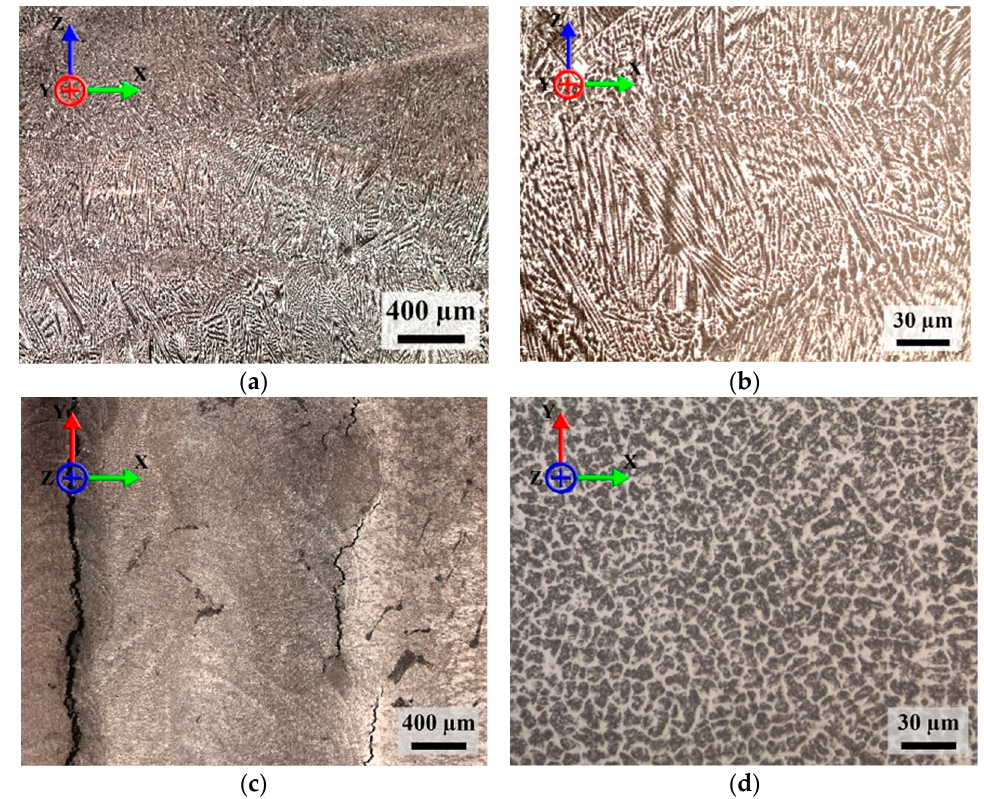
Figure 6. Microstructure of a H13 steel sample L-DED manufactured with US, where ( a ) and ( b ) are the perpendicular direction ( Y ), in line with the building direction, and ( c ) and ( d ) are the longitudinal direction ( X ).